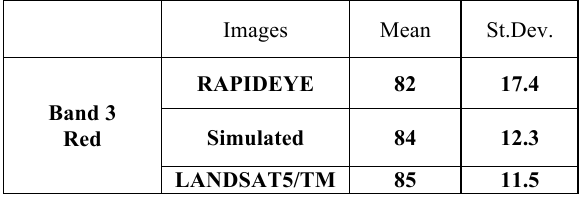
Table 4. Average Values and Standard Deviation for the presented images.